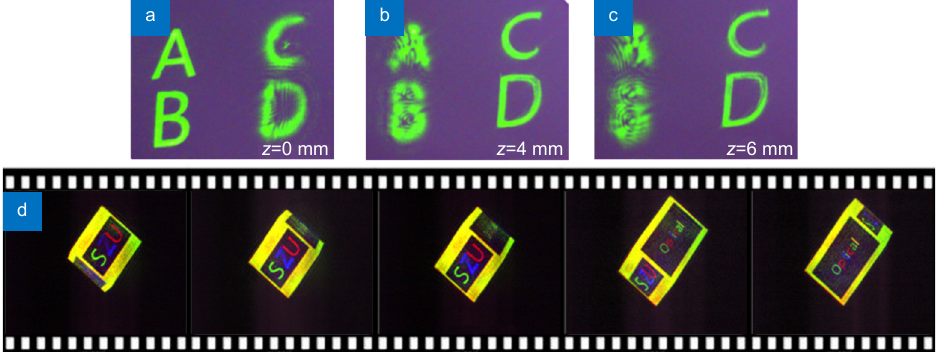
Fig. 6 | Optical reconstructions of 3D display with different focal plane locations. ( a ) Focus on z =0. ( b ) Focus on z =40mm. ( c ) Focus on z =60 mm. ( d ) Dynamic full-color digital holographic